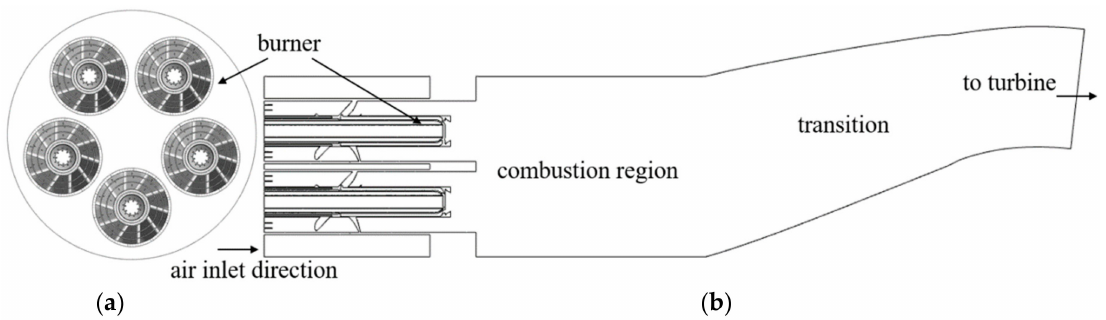
Figure 3. Schematic diagram of DLN2.0+ single tube combustor. ( a ) Burner inlet view; ( b ) Side view of combustion chamber